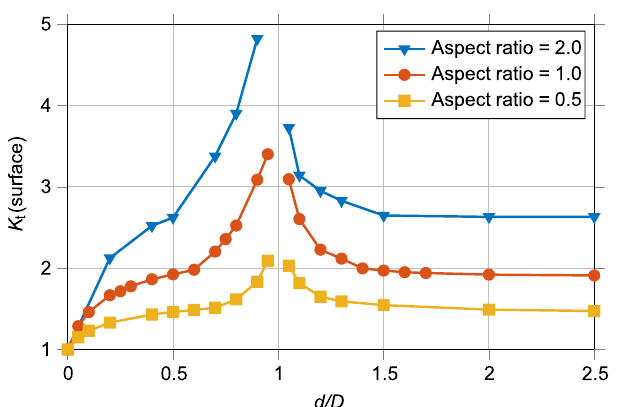
Figure 6. The stress concentration ( K t ) generated by a pores proximity to a free surface – The maximum increase in stress predicted by linear elastic FE modelling of pores at various depths ( d ) from the surface, normalised by the pore diameter ( D ) normal to the loading vector. Results are shown for idealised spheres/ oblate spheroids with three different aspect